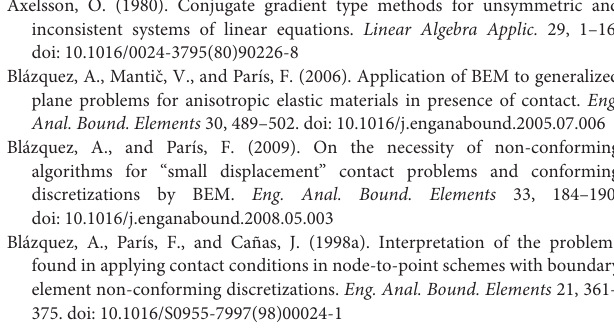
and also successfully compared to other well established BEM methodologies as well as a commercial FEM